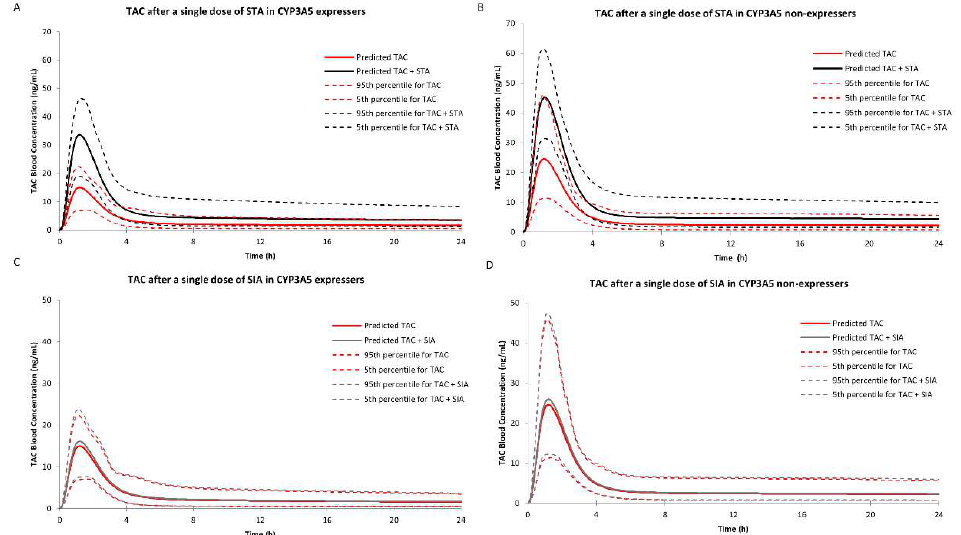
Figure 6. Simulations of blood concentration-time profiles of tacrolimus after a single oral dose of 7.325 mg STA, 7.20 mg SIA in CYP3A5 expressers ( A and C ) and CYP3A5 non-expressers ( B and D ) by Simcyp ® .